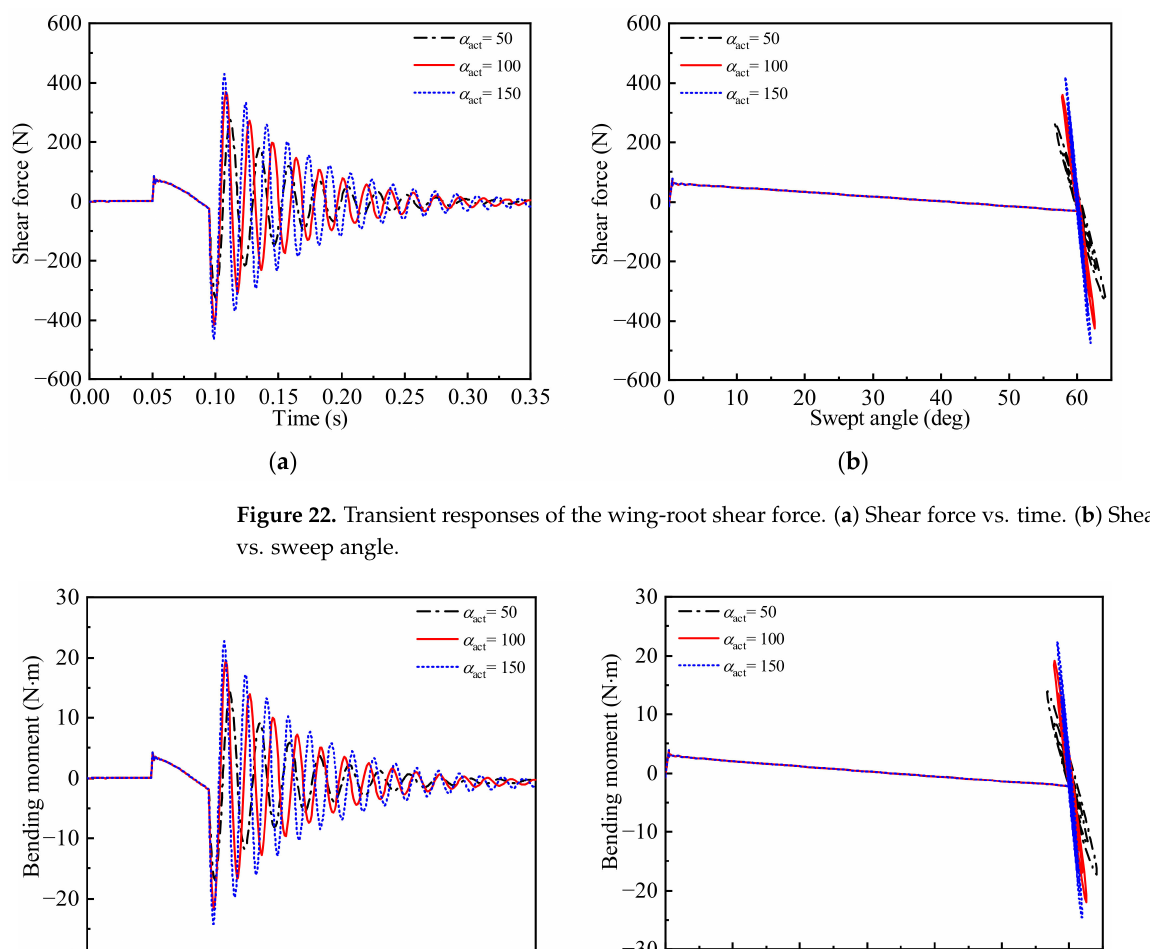
Figure 21. Transient responses of the rotational moment. ( a ) Rotational moment vs. time. ( b ) Rotational moment vs. sweep angle.